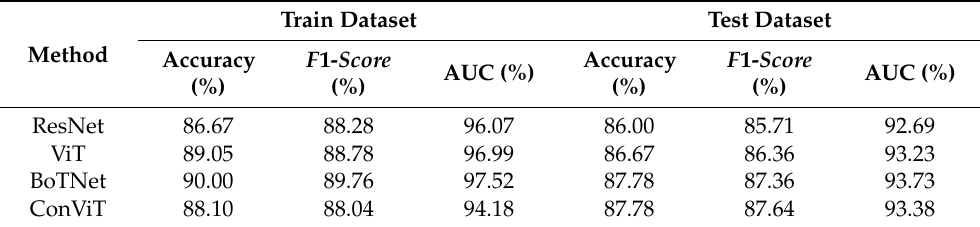
Table 3. Evaluation result of LSM